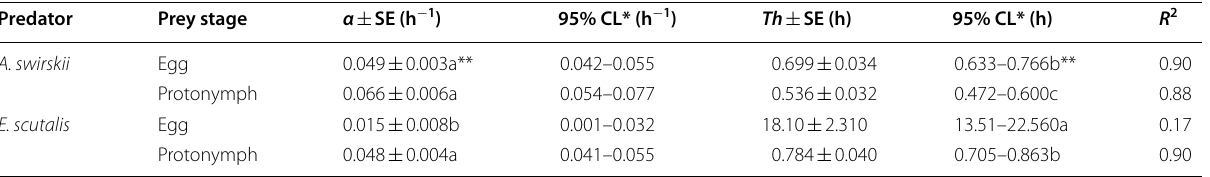
Table 3 Search rate ( α ) and capture time ( Th ) of Amblyseius swirskii and Euseius scutalis on egg and protonymph stages of Eutetranychus orientalis